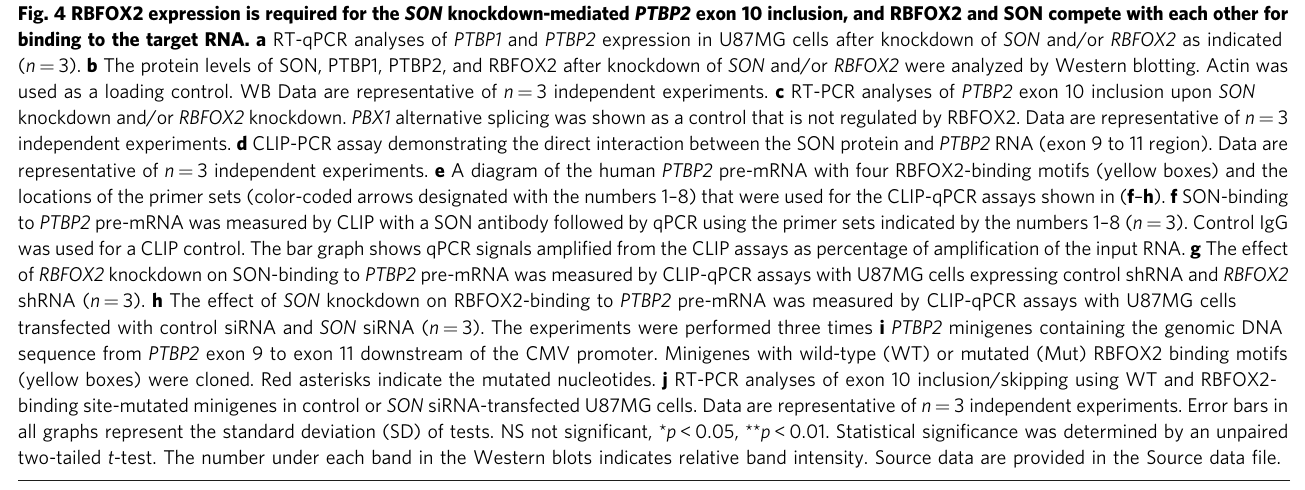
Fig. 4 RBFOX2 expression is required for the SON knockdown-mediated PTBP2 exon 10 inclusion, and RBFOX2 and SON compete with each other for binding to the target RNA. a RT-qPCR analyses of PTBP1 and PTBP2 expression in U87MG cells after knockdown of SON and/or RBFOX2 as